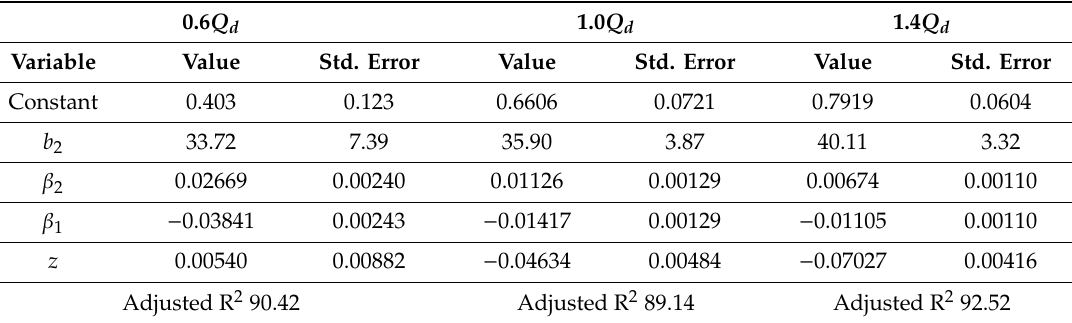
Table 11. Summary of regression